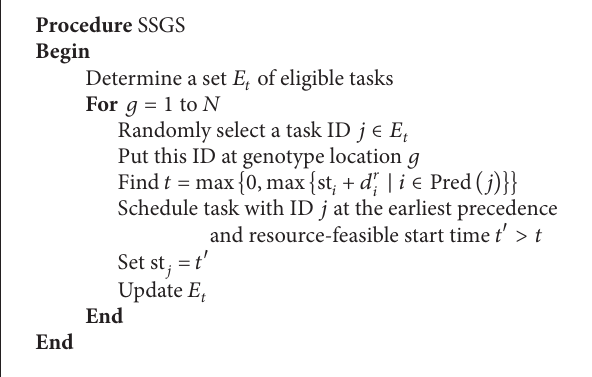
Algorithm 1: Serial Schedule Generation Scheme (SSGS) Algo-